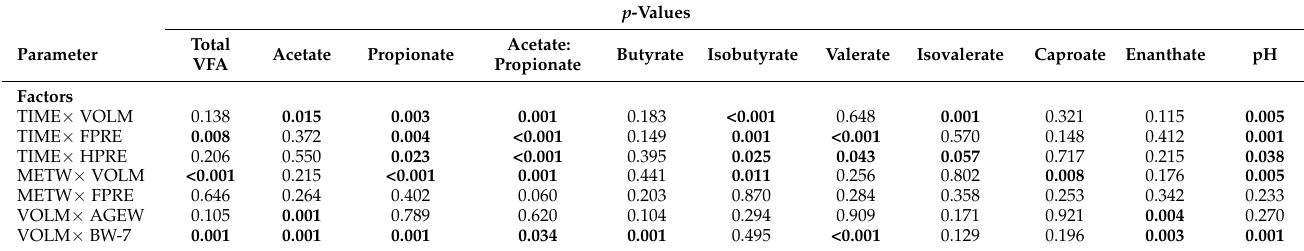
Table 6. Effect of factors as two-way interactions examined on the concentration of ruminal volatile fatty acids (VFA) and pH (factors with a significant effect in bold) values determined in 243 Holstein dairy calves of eight commercial dairy farms at 3 time-points (7 days pre-weaning ( − 7 d), weaning and 7 days